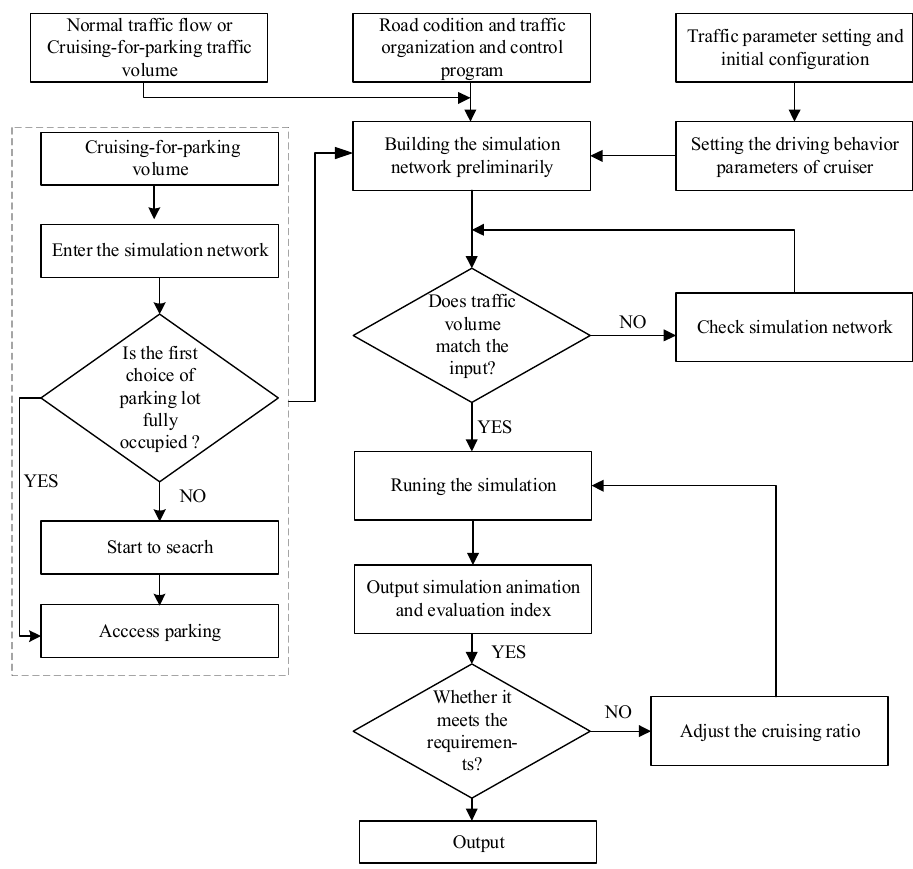
Figure 4. Framework of VISSIM simulation.